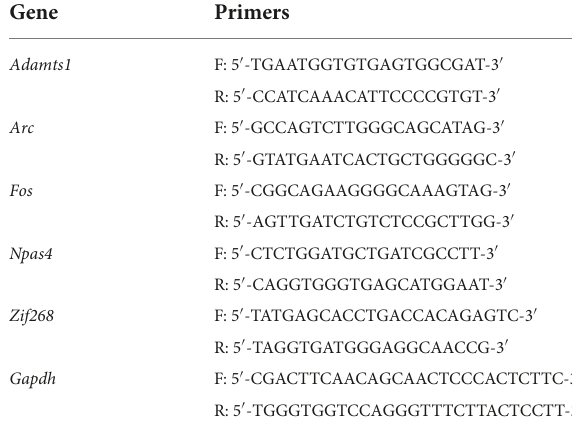
TABLE 2 Primers used in qPCR